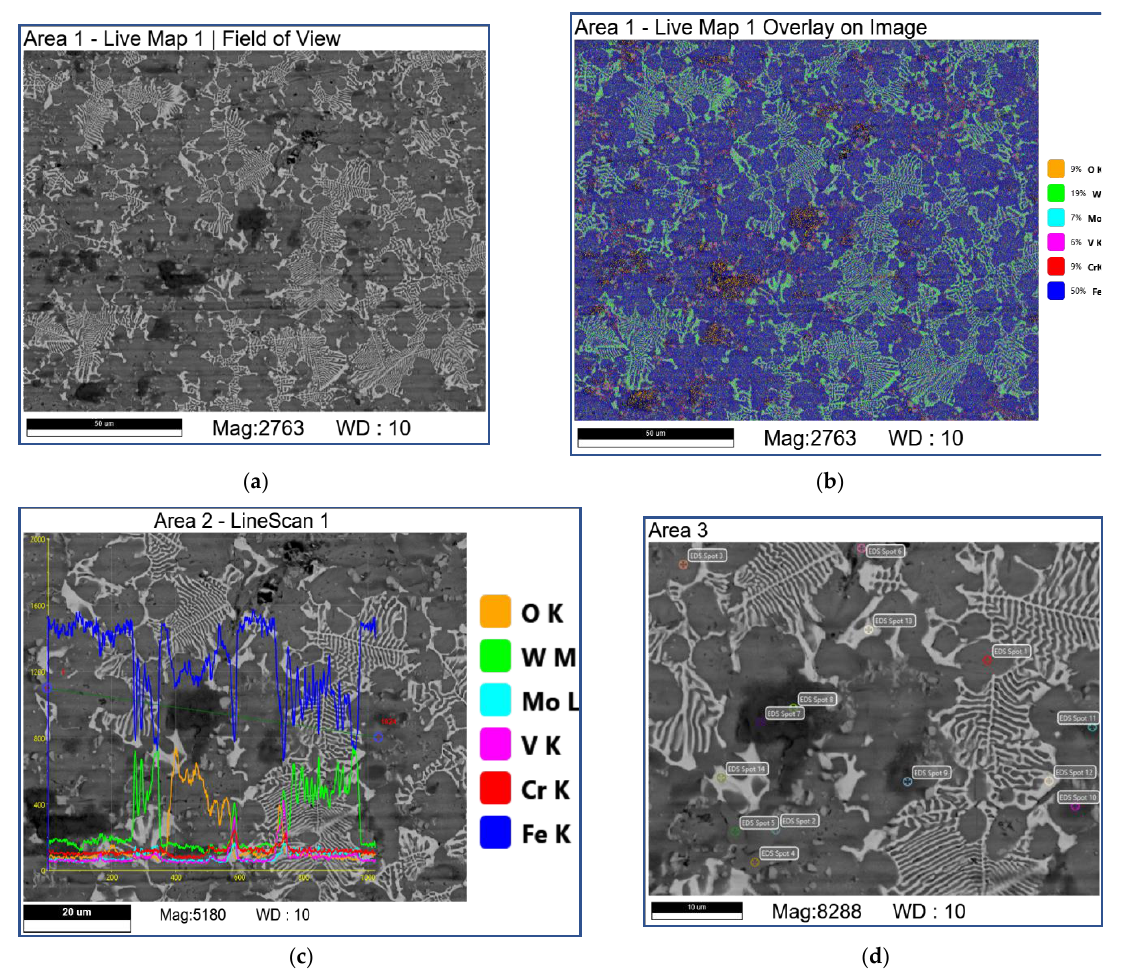
Figure 10. The SEM BSE images ( a , c , d ), overlay EDS image ( b ) and EDS line scans ( c ) of M2/W coating worn surface. Data presented for specimens after sliding speed of 1.2 m/s. Numbers on ( d ) indicate probe zones for which EDS elemental concentrations were determined indicated in Table 3. Table 3. EDS elemental composition of the M2/W worn surface on sliding at 1.2 m/s (Figure 10d). Table 2. The EDS elemental composition of coating M2/W worn surface after sliding at 0.8 m/s (Figure